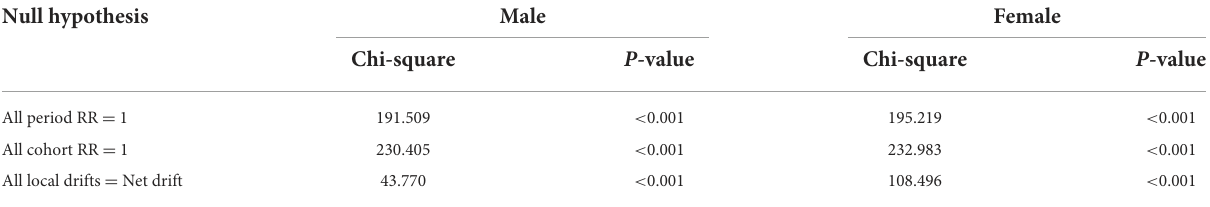
TABLE 1 The Wald chi-square test for estimable functions in the APC